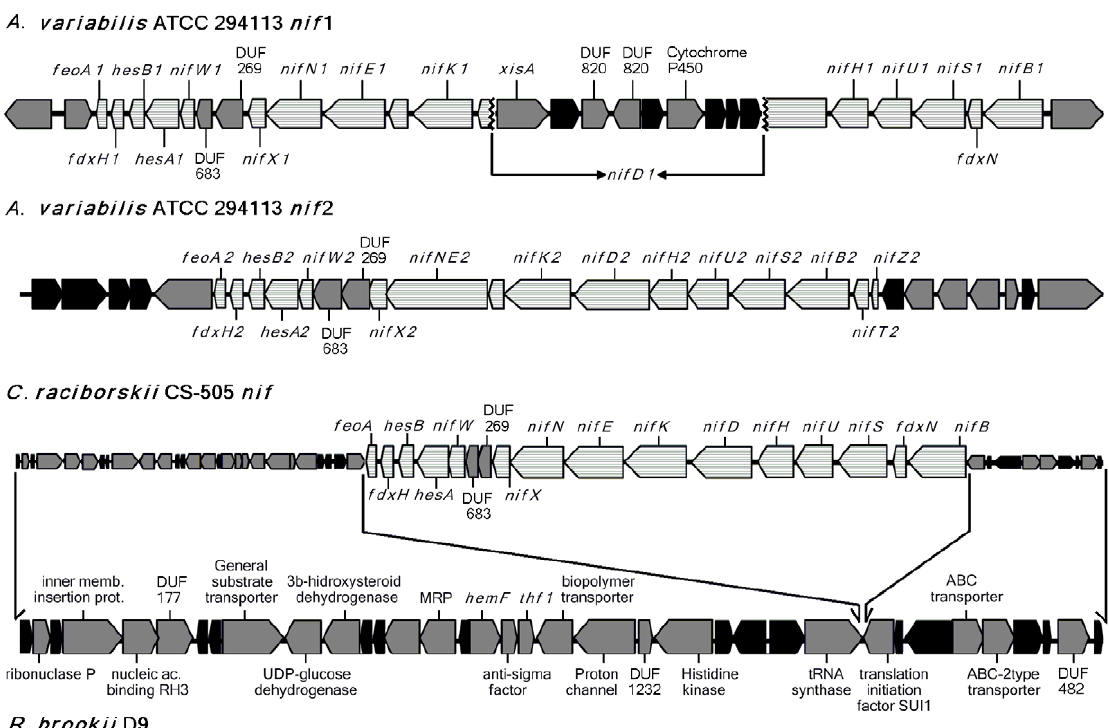
Figure 3. Schematic representation of the synteny within the vicinity of the nif gene clusters. The scheme represents the 15 kb gene cluster containing the nifHDK and the other 13 nitrogen fixation related genes in CS-505 compared with the nif 1 and nif 2 gene clusters of Anabaena variabilis ATCC 29413 and the synteny regions between CS-505 and D9. The synteny regions between CS-505 and D9 are delimited by the arrows. nif genes are represented by light grey and dashed lines. Genes in black correspond to hypothetical proteins and grey genes to proteins with assigned function.